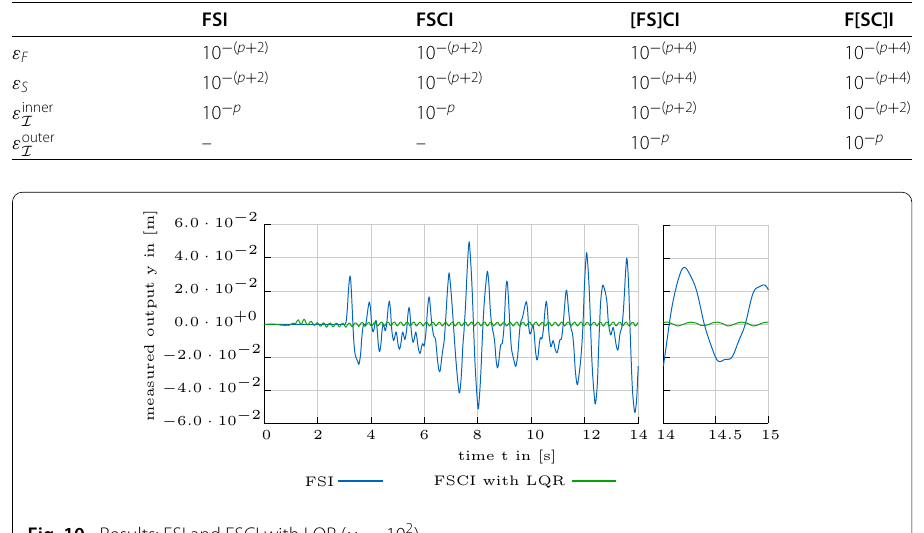
Fig. 10 Results: FSI and FSCI with LQR ( γ = 10 2 )